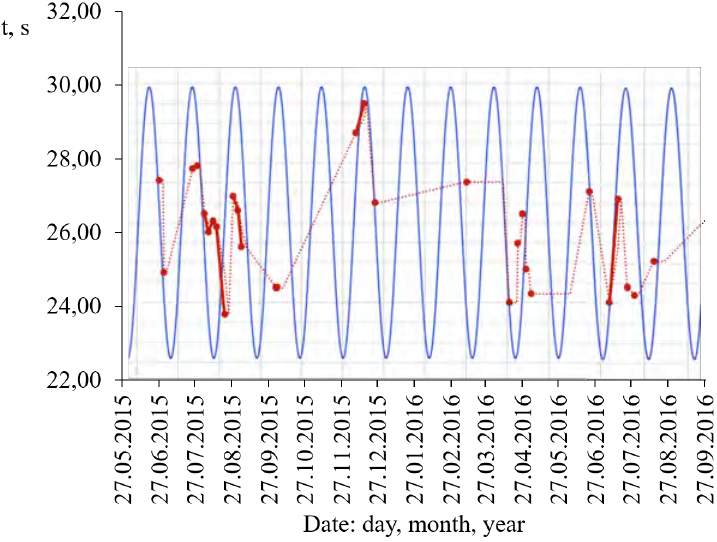
Fig. 1. Individual competitive performance of an athlete at a distance of 200 m; the period of oscillations covers several microcycles is 38